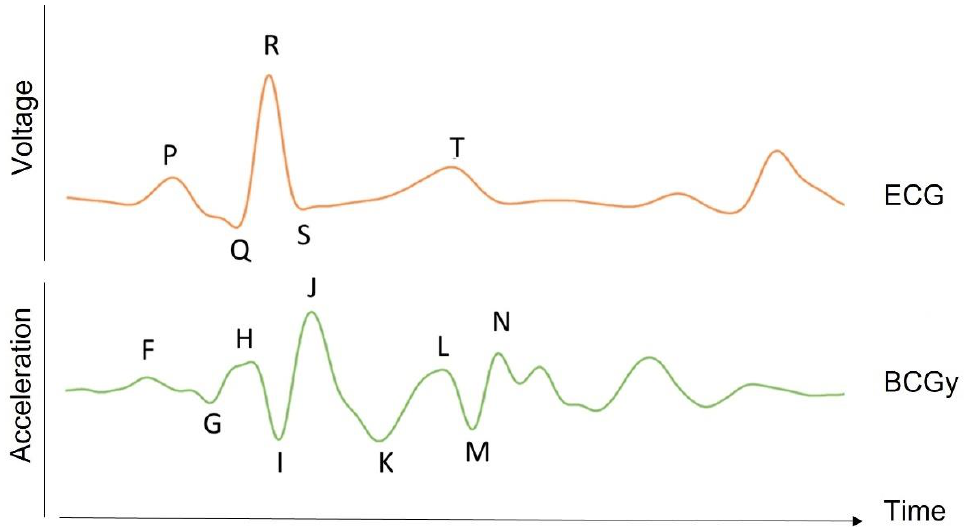
Figure 1. BCG waveform. The time traces of the BCG acceleration signal in the longitudinal axis (y) for a healthy subject are shown together with the ECG signal in one heart beat (in arbitrary unit). As opposed to the SCG, BCG represents global movements, and its waves are more difficult to associate with a single event of the cardiovascular cycle. However, the F, G, and H waves are related to events occurring before the ventricular systolic phase. Indeed, the H wave was shown to be associated with the atrial contraction, while the I and J waves are associated with the ejection of blood in the aorta and other large vessels. The K and following waves are thought to be due to the reflection of the pressure wave at the peripheral vessels and to the resulting oscillations in the center of mass of the overall blood volume.